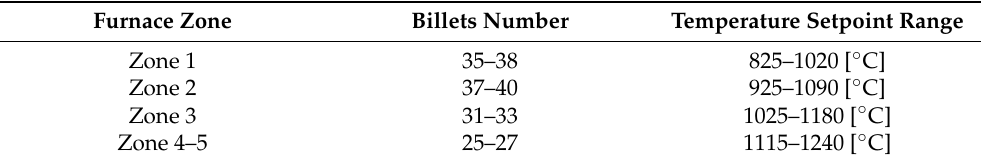
Table 2. Furnace zones